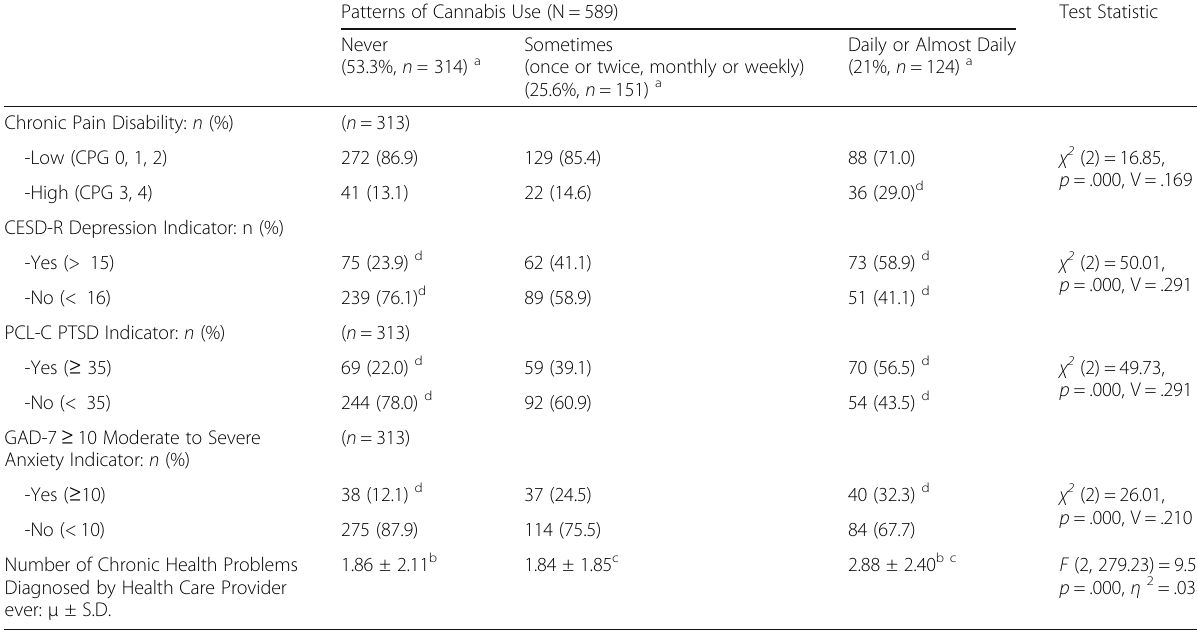
Table 5 Patterns of cannabis use in past year by health indicators for total sample ( N = 589) Patterns of Cannabis Use (N = 589) Test Statistic